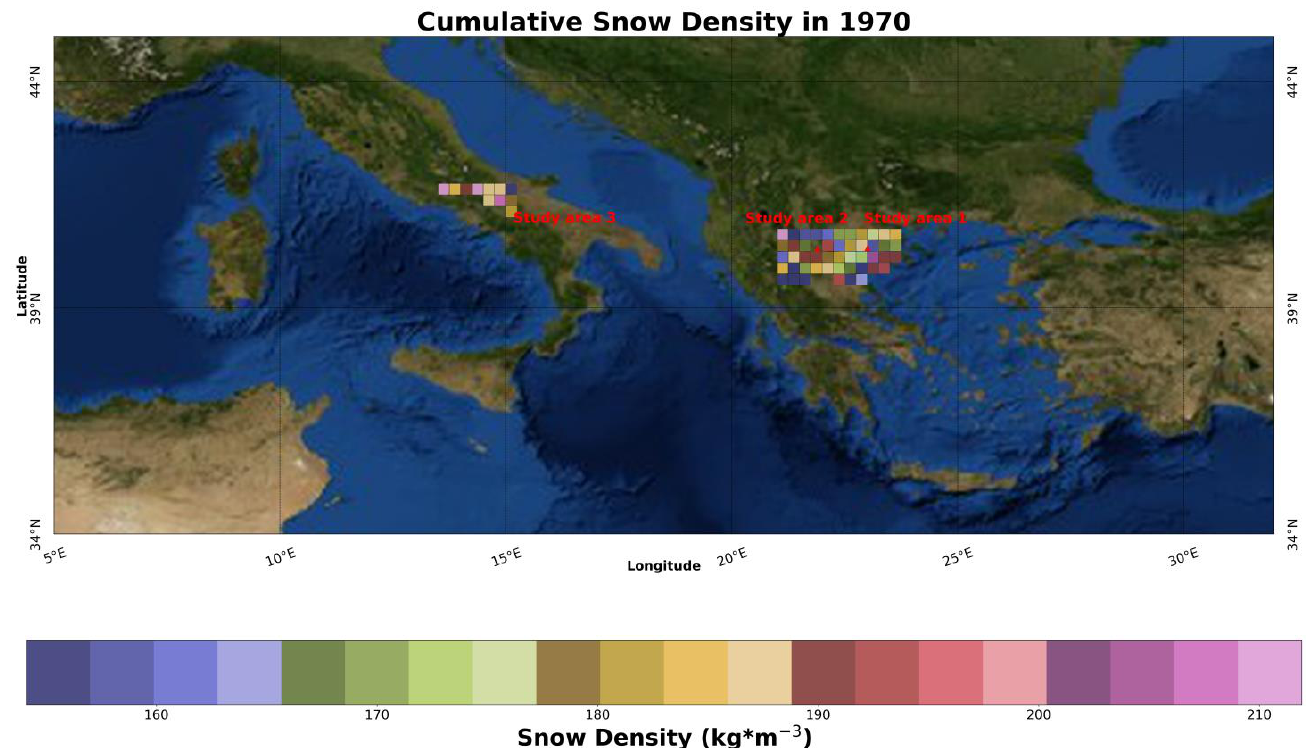
Figure 4. Cumulative snow density (kg/m 3 ) in 1970, estimated over the study areas.